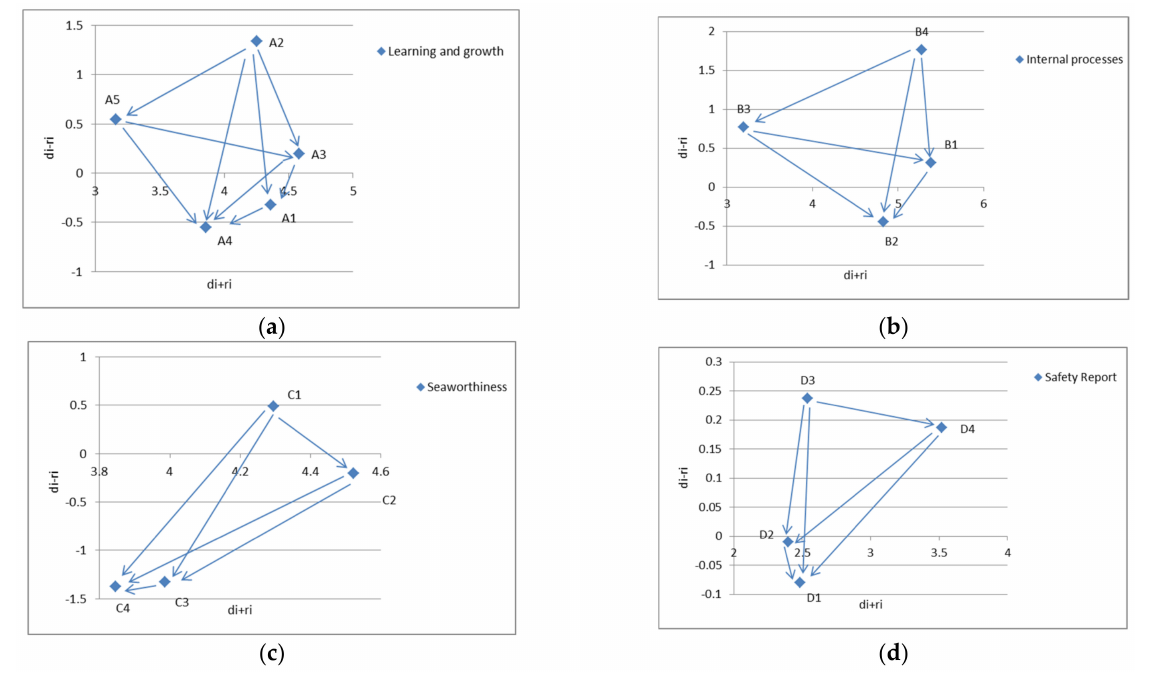
Figure 3. Causal diagram of total relationships. ( a ): Learning and growth criteria; ( b ): Internal pro-